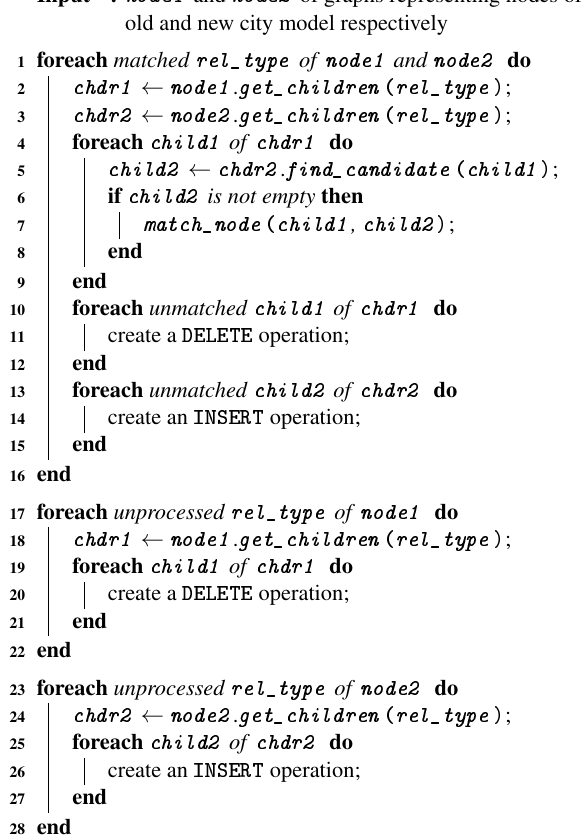
Figure 4. An example of a graph representing a Grid object. Rounded rectangles represent nodes. Node properties are displayed below nodes’ label. The colours indicate the originating classes, in which nodes and properties are defined. The container GRID node is expanded successively for each superclass.